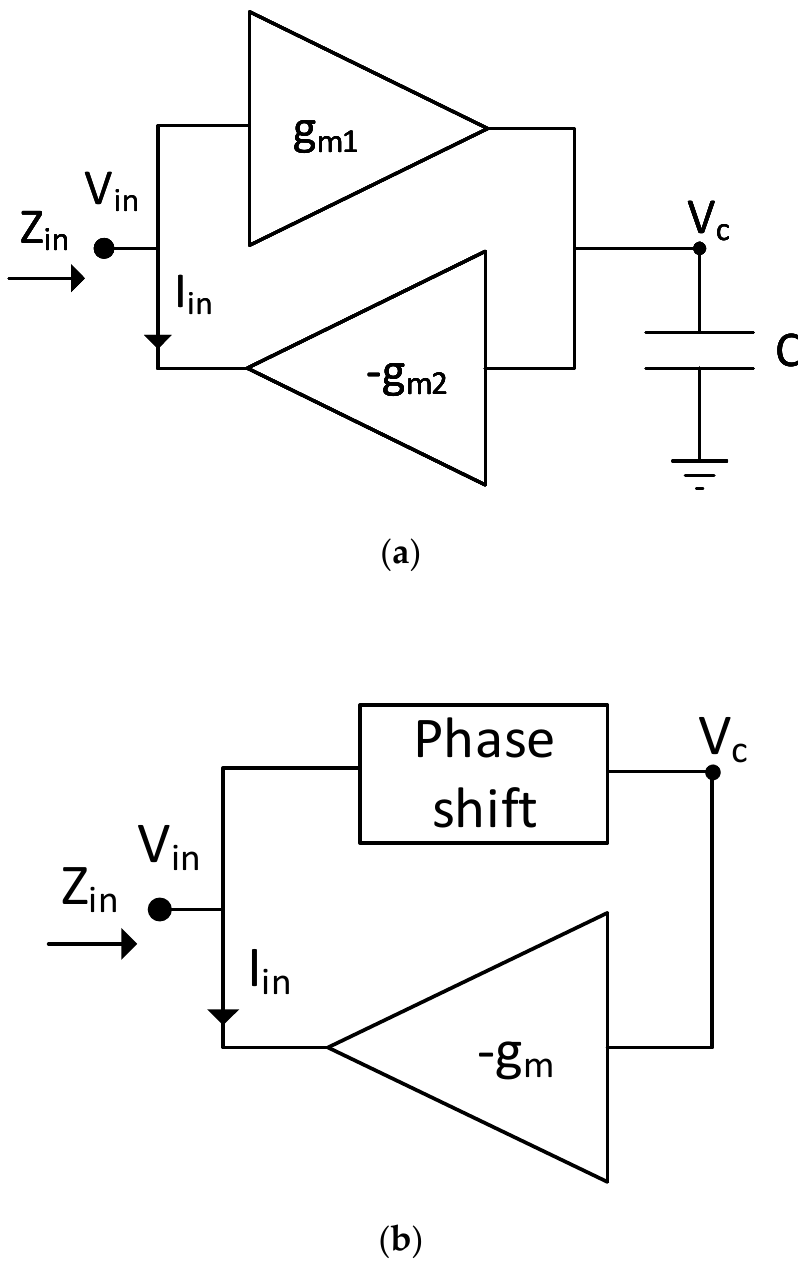
Figure 2. Active inductor architecture: ( a ) Traditional topology, ( b ) improved topology.